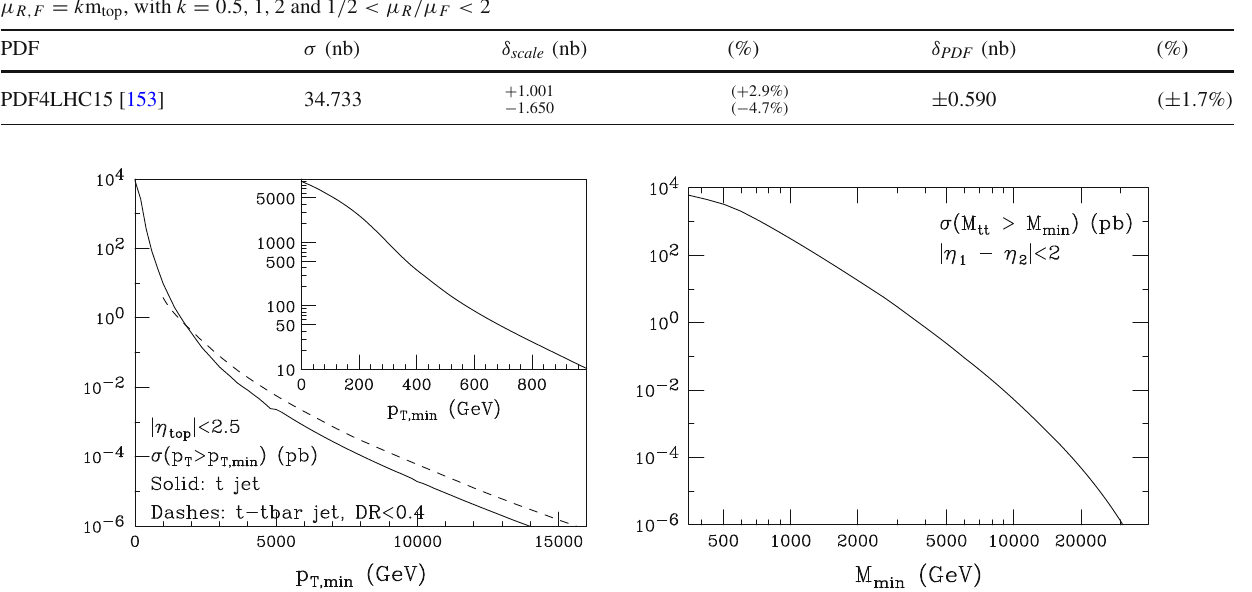
Fig. 6.5 Examples of production of top quarks at FCC-hh at high Q